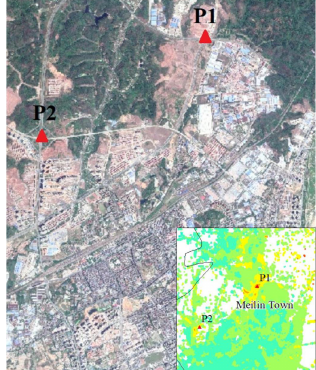
Figure 10. Surface subsidence rate around P4 and surrounding satellite image